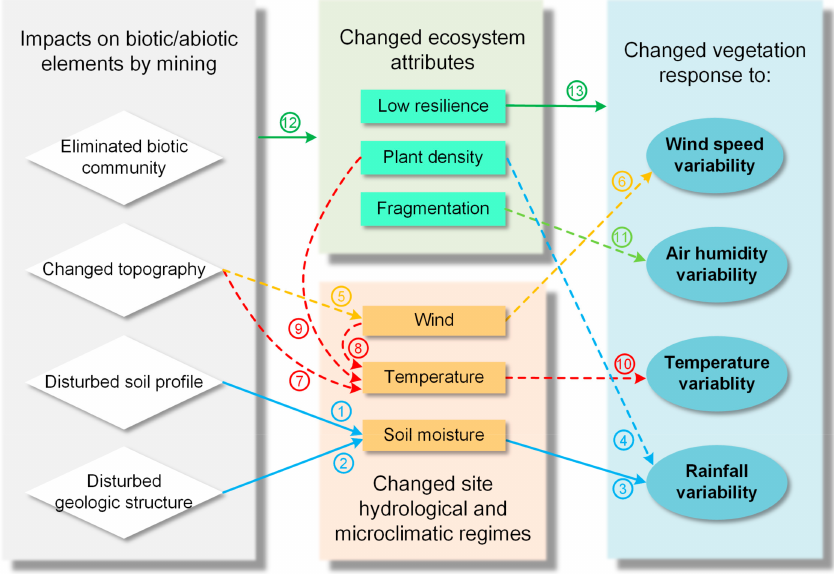
Figure 7. How surface-mining impacts changed ecological site response to climatic